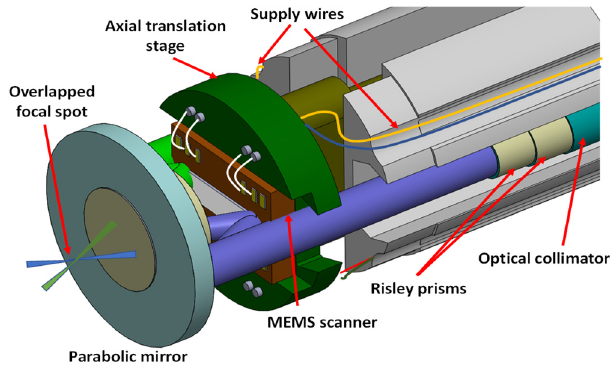
Figure 9. Schematic of a dual-axis confocal microscope with a MEMS scanning mirror and a parabolic mirror to focus two incoming collimated beams [59].